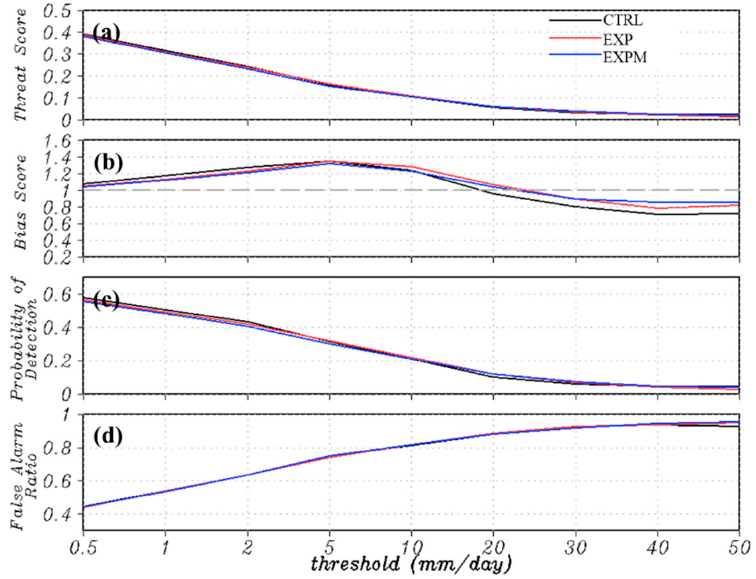
Figure 2. ( a ) Threat score, ( b ) bias score, ( c ) probability of detection, and ( d ) false alarm ratio of precipitation averaged over Asia (5° S~55° N, 60° E~180° E) from 14 May to 23 May 2020 for 48–72 h accumulated rainfall with different thresholds from the CTRL (black line), EXP (red line) and EXPM (blue line) experiments.